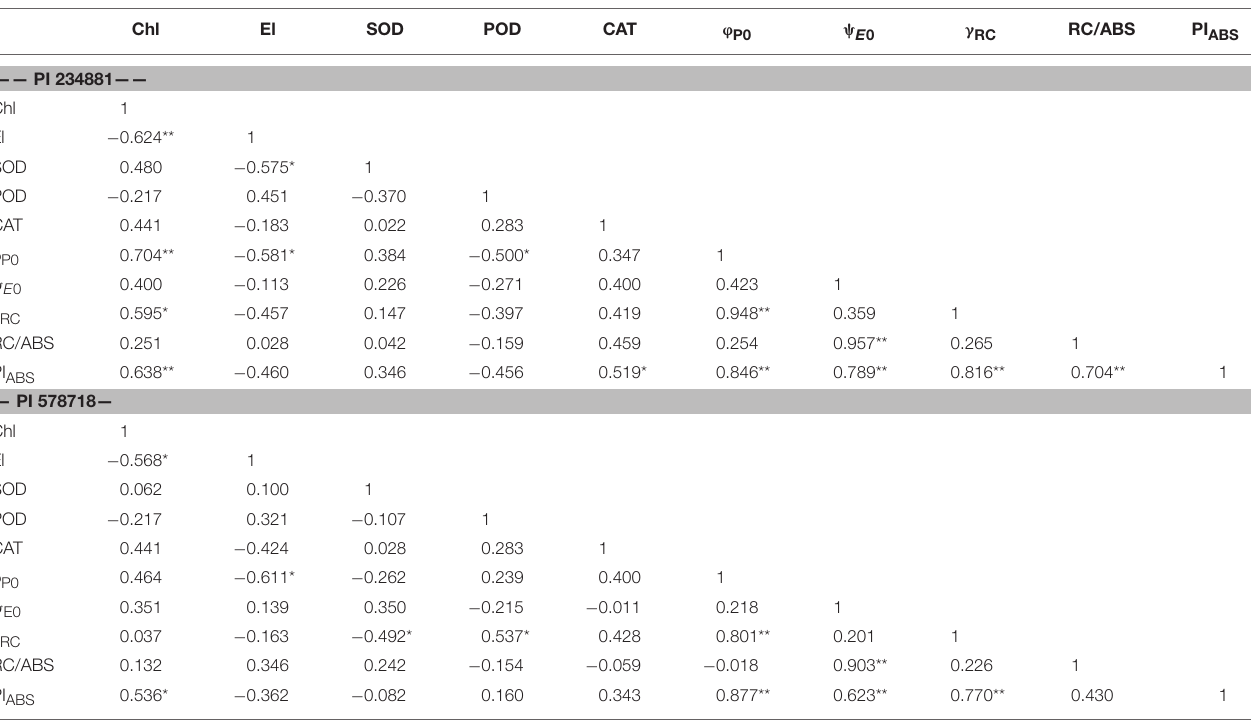
* Indicates statistical difference significance at P < 0.05 among the treatments by Duncan’s multiple range tests. ** Indicates statistical difference significance at P < 0.01 among the treatments by Duncan’s multiple range